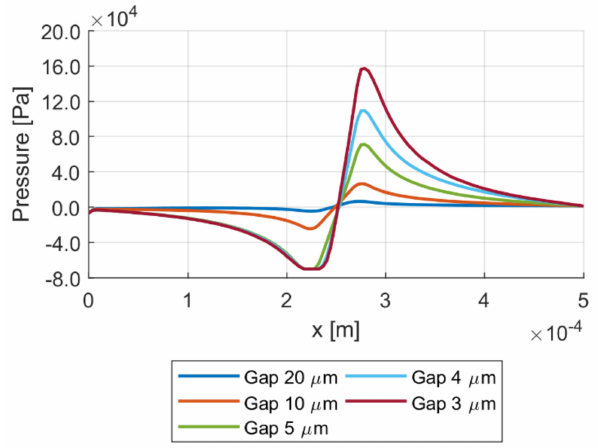
Figure 6. Pressure profile of a square dimple with side of 50 µ m and depth 10 µ m for di ff erent values of the gap. Sliding velocity 5 m /